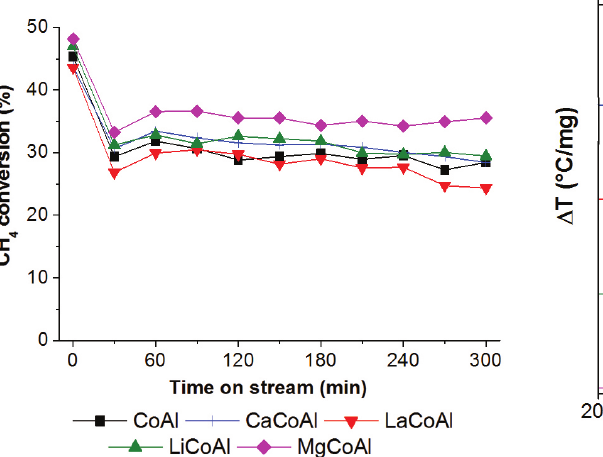
Figure 6. CO conversion vs. reaction temperature. 2